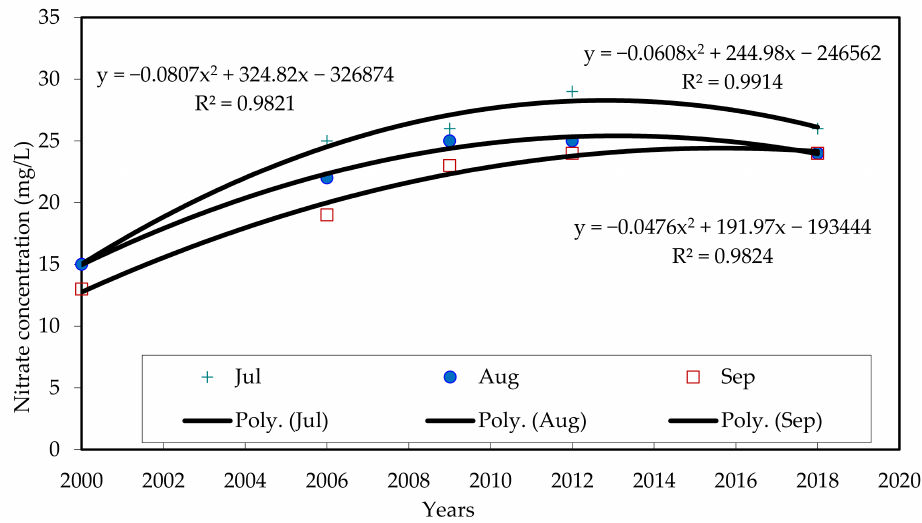
Figure 5. Trendiness of nitrate in the wellfield water considering July, August and September